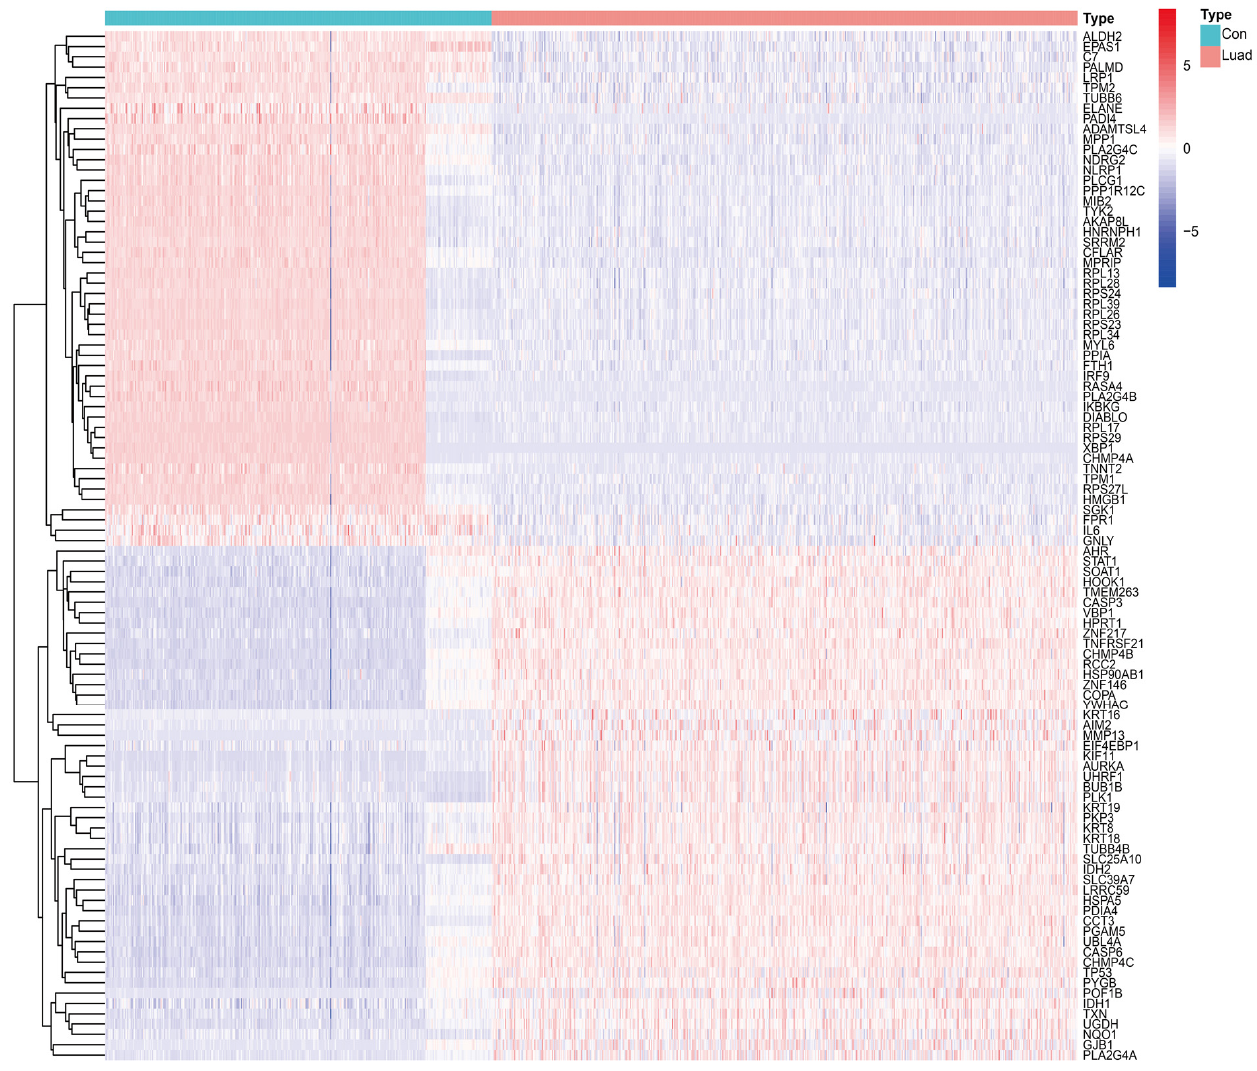
Figure 2. Heat map of NRG expression in LUAD and normal tissues.